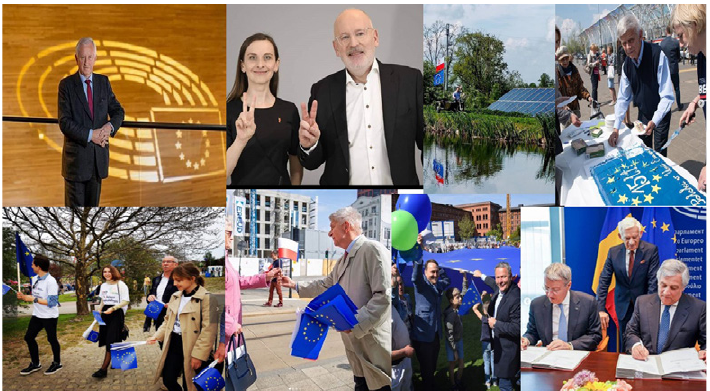
Figure 5. Photos of candidates constructing the notion of belonging and “Europeannes” ( topos of the cosmopolitan official) (source: Instagram